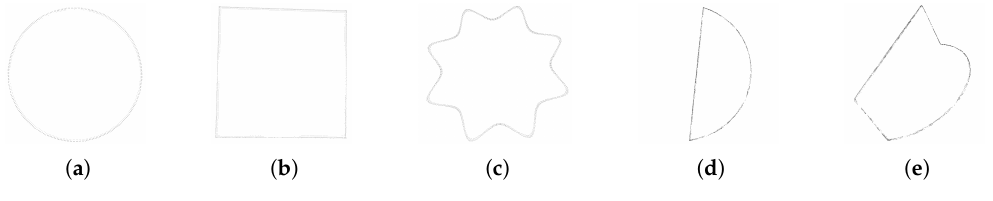
Figure 9. Set of testing point clouds: ( a ) C 1 , ( b ) C 2 , ( c ) C 3 , ( d ) C 4 , ( e ) C 5 . Table 4. The testing curves—number of points s in